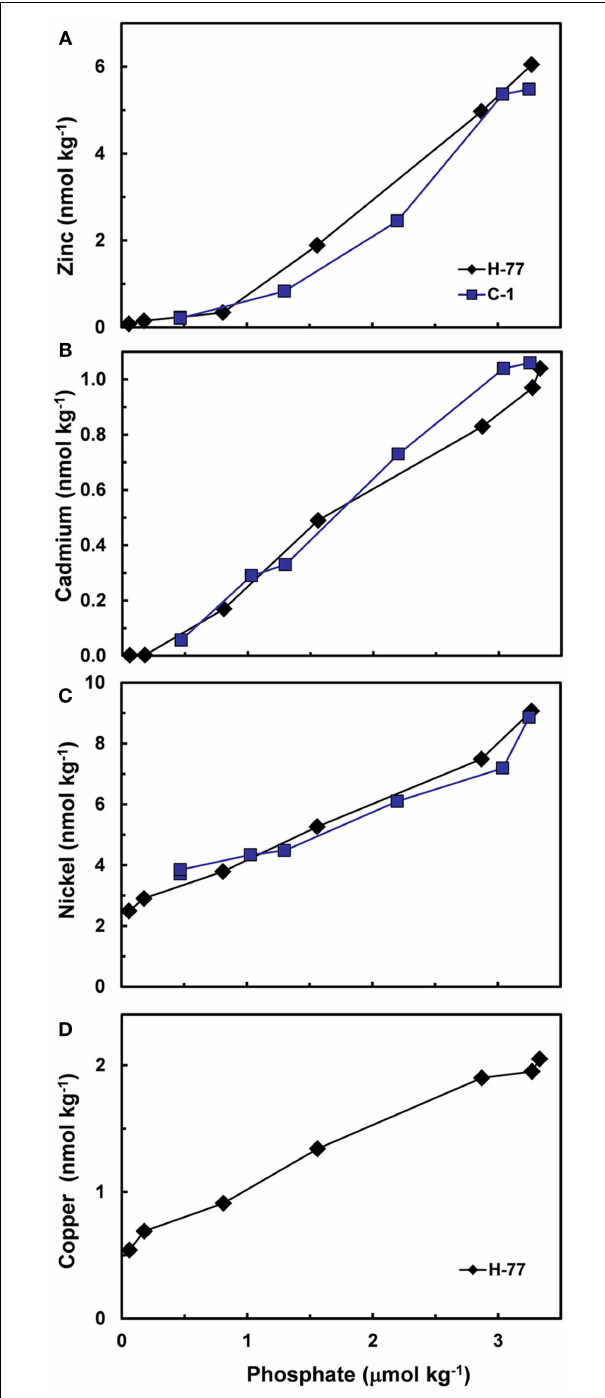
FIGURE 4 | Plots of concentrations of (A) Zn, (B) Cd, (C) Ni, and (D) Cu vs phosphate within the nutricline of the northeast Pacific (upper 800–1000m) at stations H-77 and C-I (Bruland,